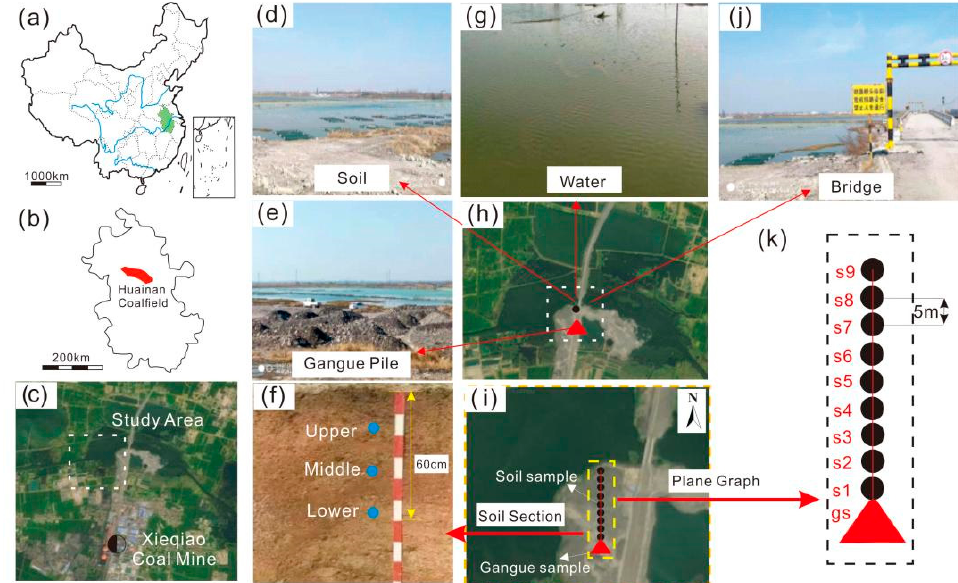
Figure 1. Location map of the study area and overview of sample collection. ( a ) The territory of China, and the green part is the province where the study area is located; ( b ) Huainan coalfield where the study area is located; ( c ) the study area is located to the south of Xieqiao coal mine; ( d ) sampling location—soil; ( e ) sampling position—coal gangue pile; ( f ) sampling interval of soil profile; ( g ) surrounding water bodies; ( h ) enlarged view of the location of the study area; ( i ) enlarged layout of sampling points for coal gangue and soil; ( j ) roads around the study area; ( k ) enlarged layout of coal gangue and soils sampling points.